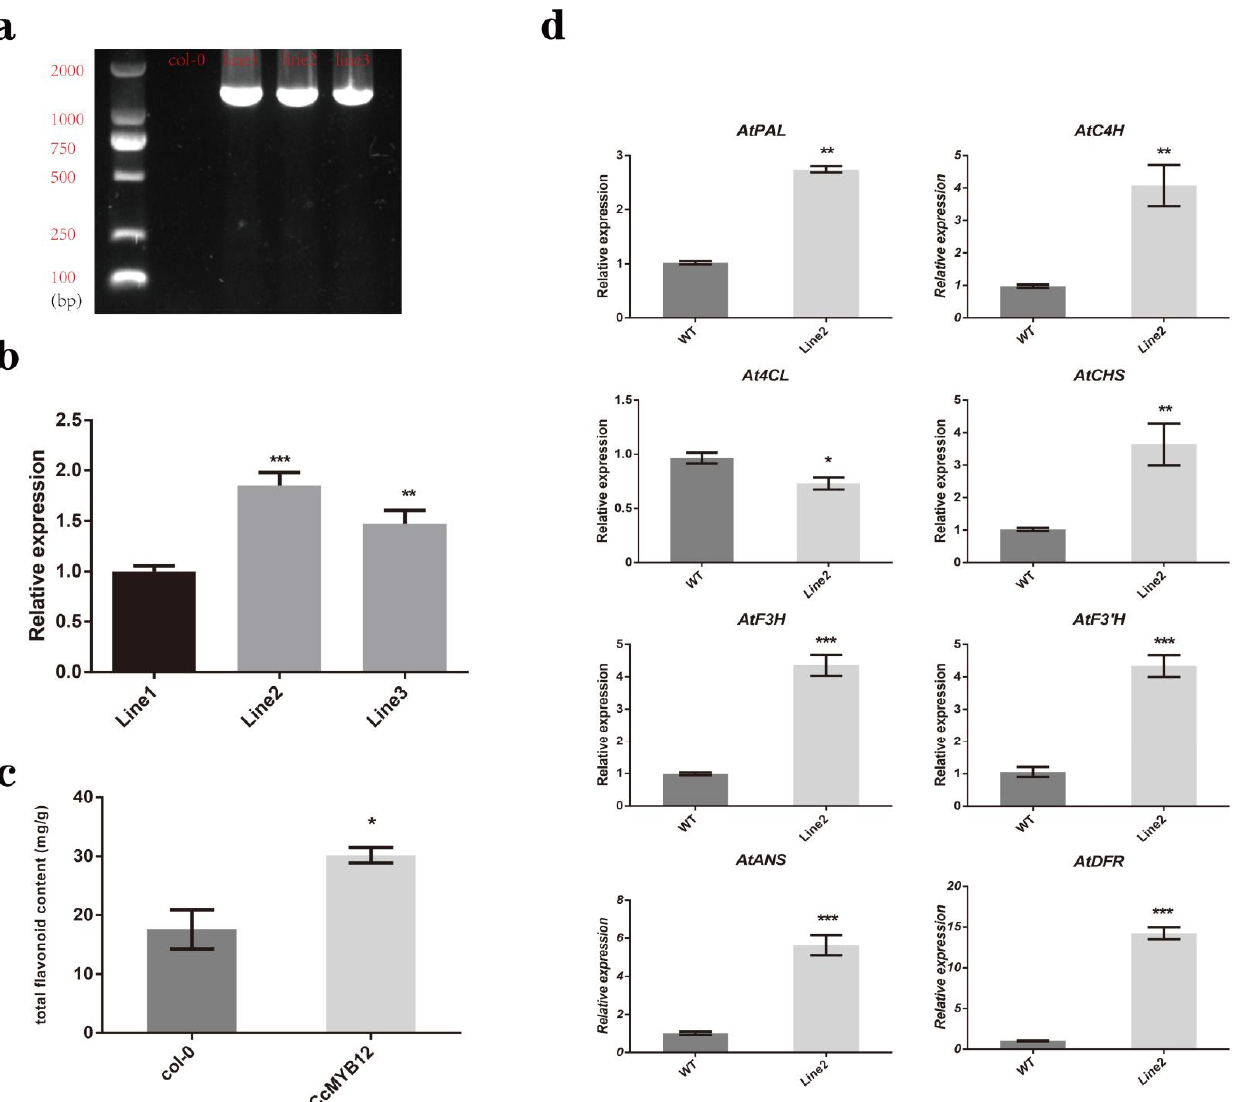
Figure 7. CcMYB12 can increase total flavonoid content and regulate some genes required for fla- vonoid synthesis. ( a ) Homozygous T3 Arabidopsis seeds contained CcMYB12 gene. ( b ) CcMYB12 genes showed different expression levels in three transgenic lines. ( c ) CcMYB12 overexpressing line